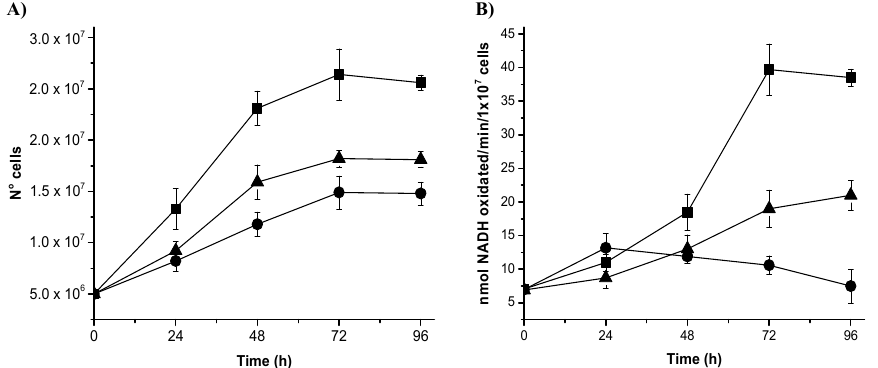
Figure 3. Kinetics of cell growth ( A ) and NADHox enzyme activity ( B ) from the wild type (WT) strain ( (cid:4) ) and N200 ( ) and N400 ( (cid:78) ) transformants. The figures represent the average of three independent experiments. However, each of these three experiments were performed in triplicate, so the standard deviation is the reflection of 9 replicates at each time. For all experiments, the standard deviation was less than